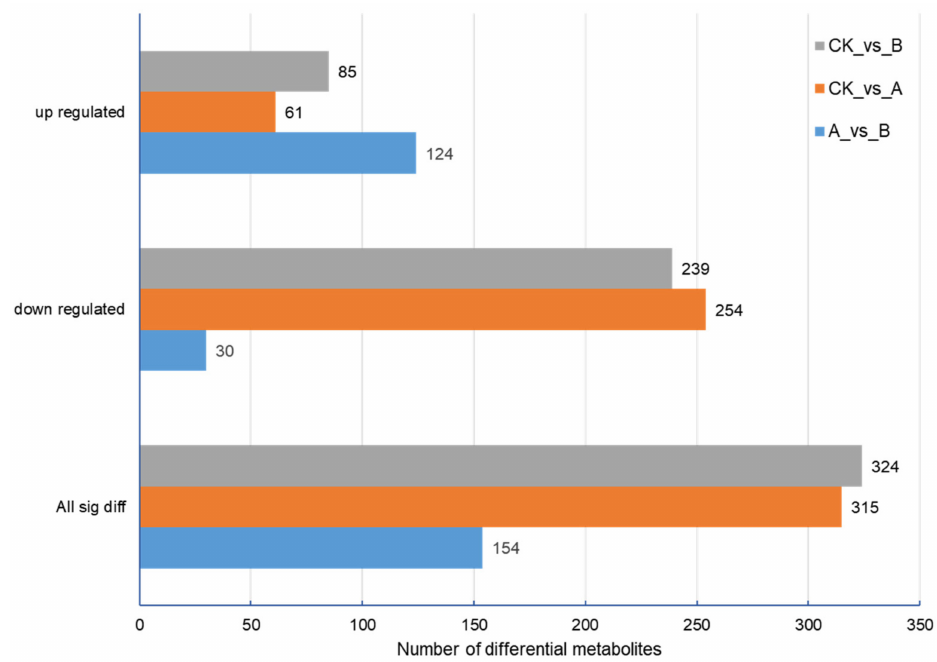
Figure 6. Statistics concerning the number of differential